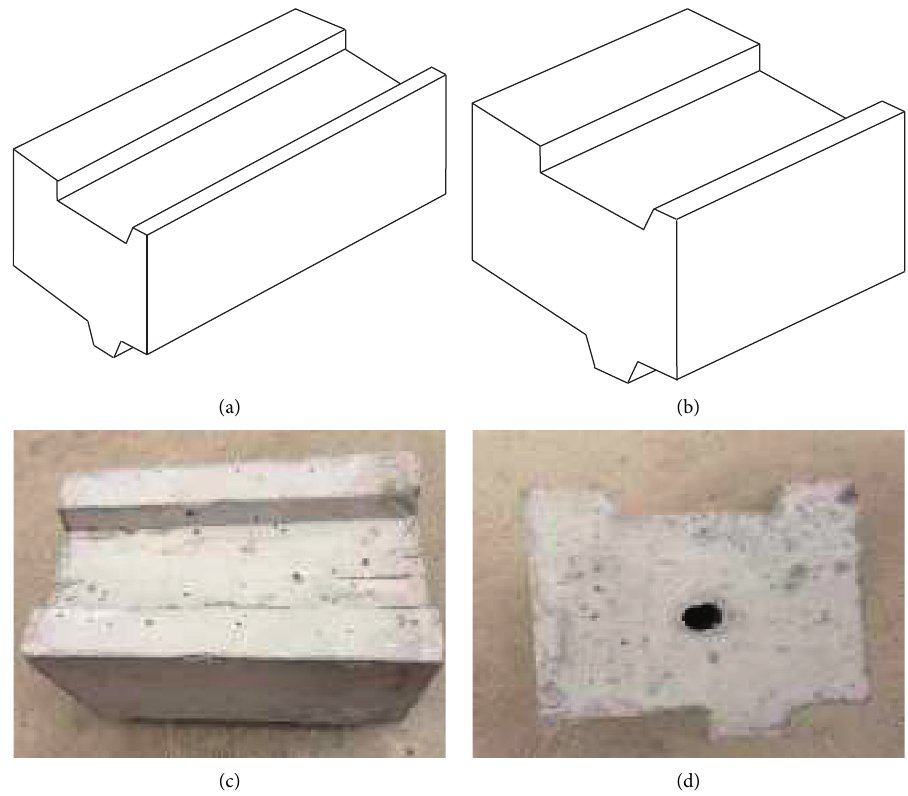
Figure 4: Modular block. (a) Block sample 1. (b) Block sample 2. (c) Model block front. (d) Model block side.